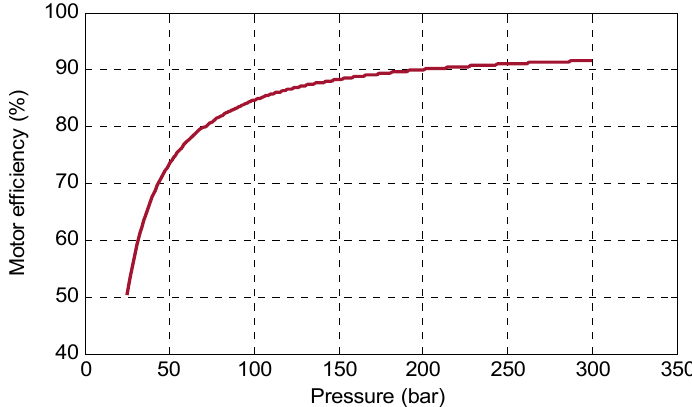
Figure 3. Generic motor efficiency versus pressure.